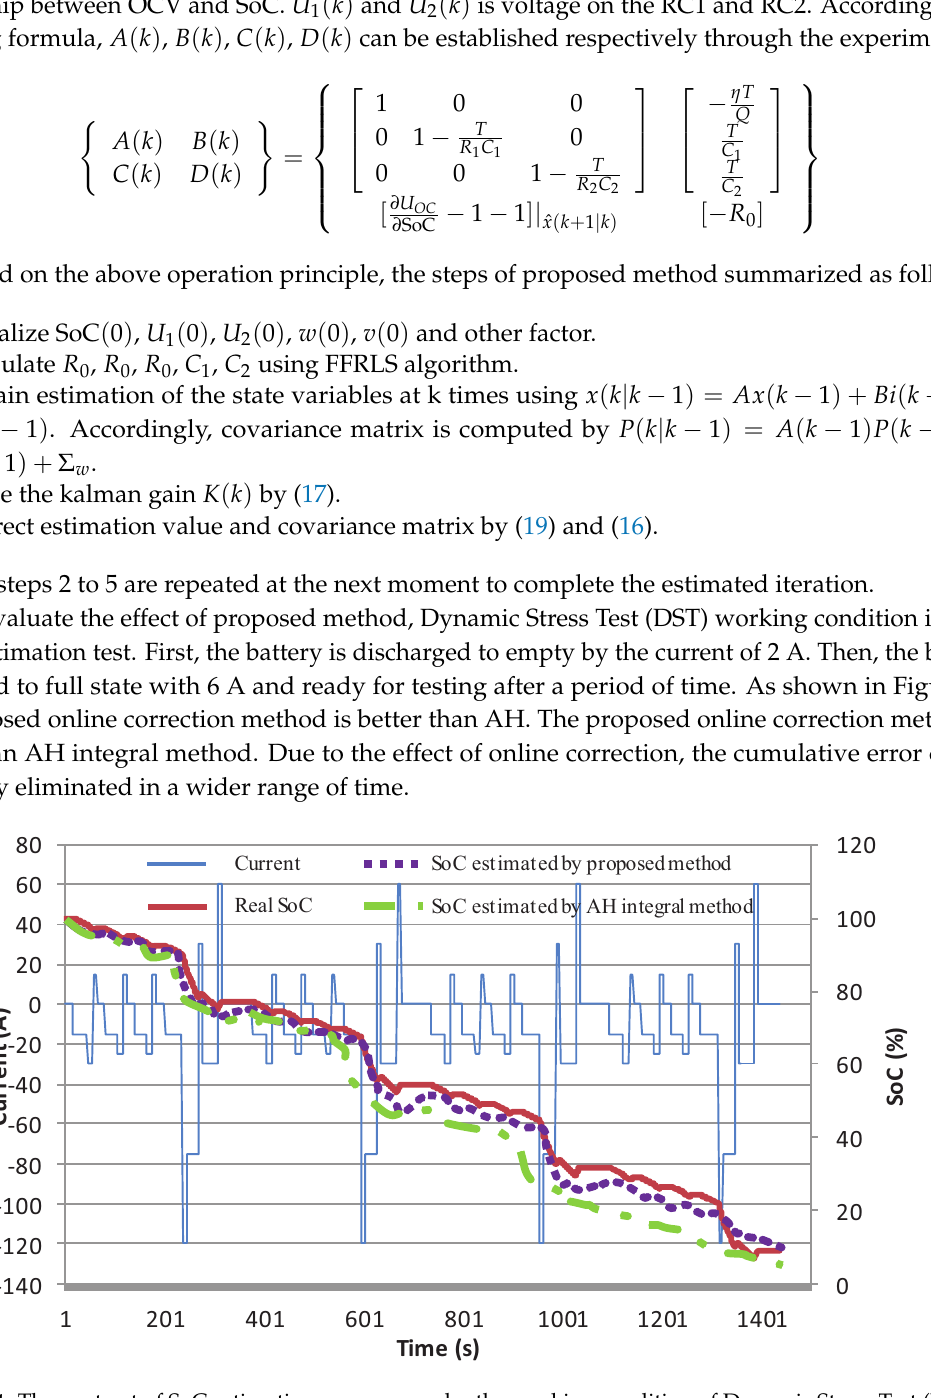
Figure 11. The contrast of SoC estimation accuracy under the working condition of Dynamic Stress Test